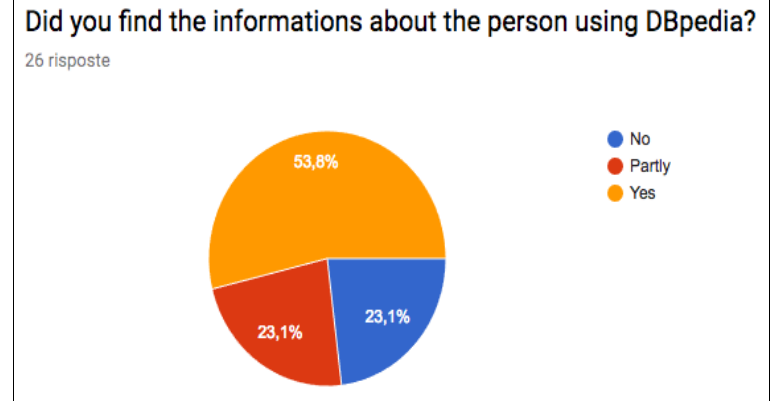
Figure 11. Information on people retrieved through DBpedia